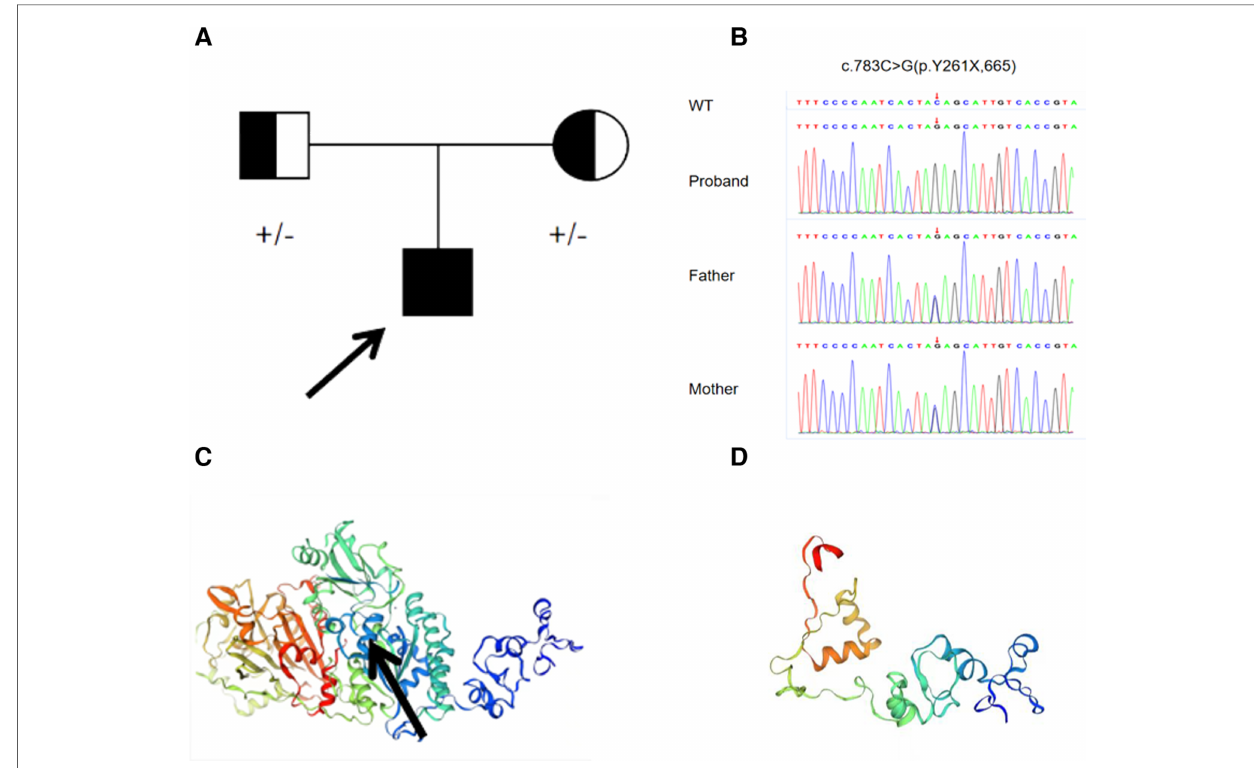
FIGURE 2 ( A ) family history of the proband. ( B ) Sanger sequencing revealed a homozygous mutation (c.783C>G p .Y261X) of ENPP1 in the proband boy, originating from his parents. ( C ) Normal protein structure; the black arrow represents the mutation site. ( D ) Structure of the mutated